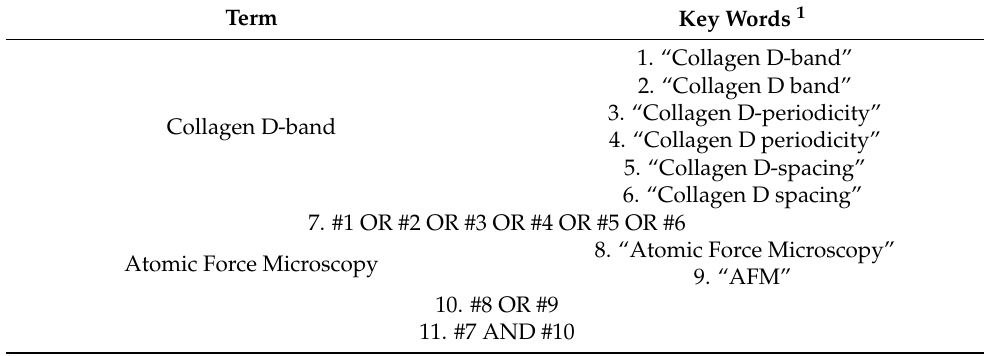
Table 1. Search Strategy. This table presents the keywords that were used in order to identify the relevant